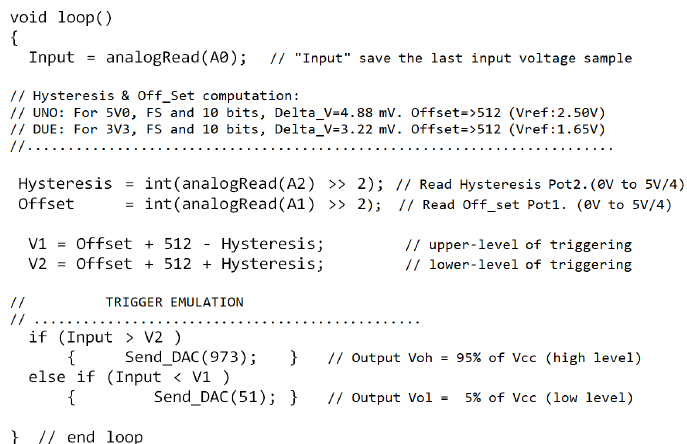
Figure 8. Code example for a functional ‘Schmitt-trigger’ emulation.